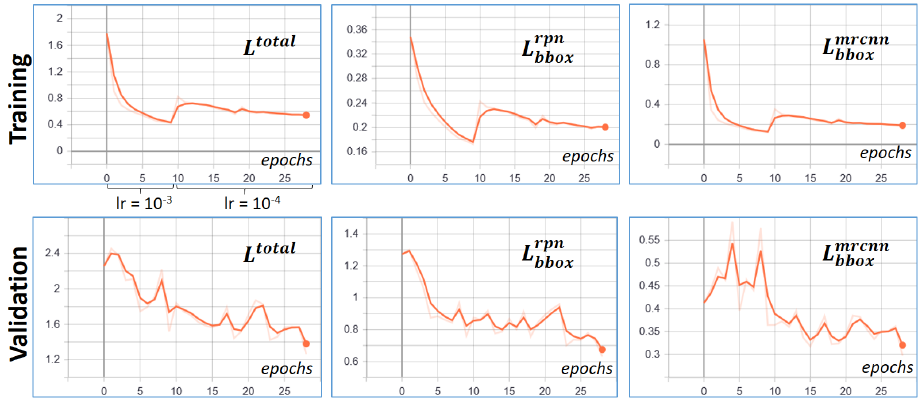
Figure 4. TensorBoard (monitoring tool for DL) plots of the loss for the training (top plots) and vali- dation (bottom plots) dataset are displayed. In addition to the total loss (left), the most important loss contributions are shown: L RPN and L rrcnn . The learning rate is set to 10 − 3 with the 10 first epochs, then bbox bbox set to 10 − 4 up to epoch